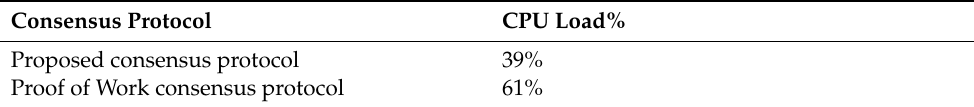
Table 3. CPU load